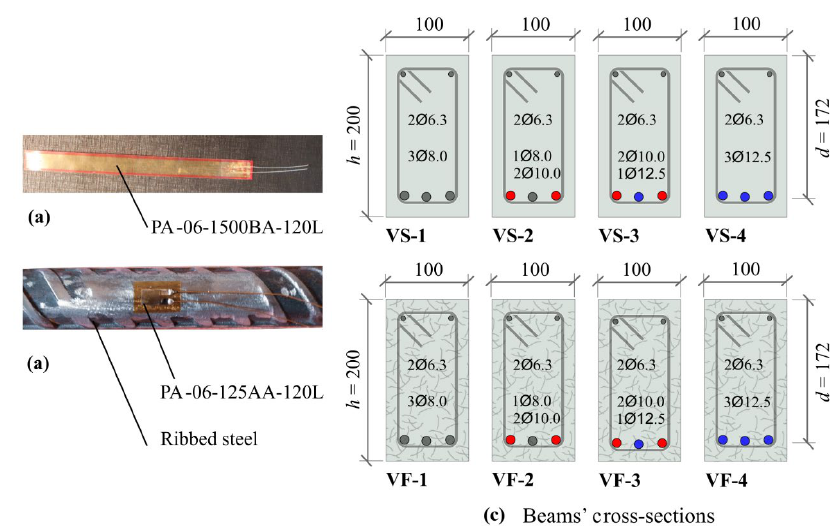
Figure 4. (a) Strain gauges model used for the concrete ( EER c ), (b) Strain gauge on steel bar ( EER s ) and (c) Detailing of beam